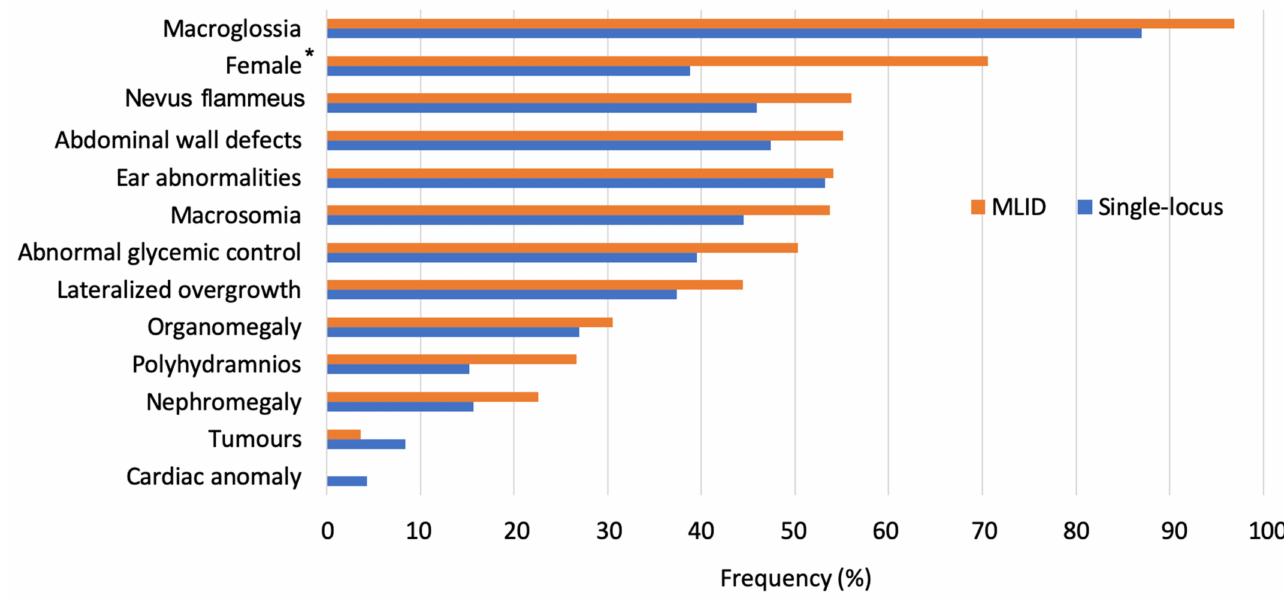
Figure 3. Frequency distribution of clinical features in BWS patients with MLID (orange) and with single-locus defects (blue) [5,8,23,24,28,33]. * p -value = 0.0314 at Fisher’s exact